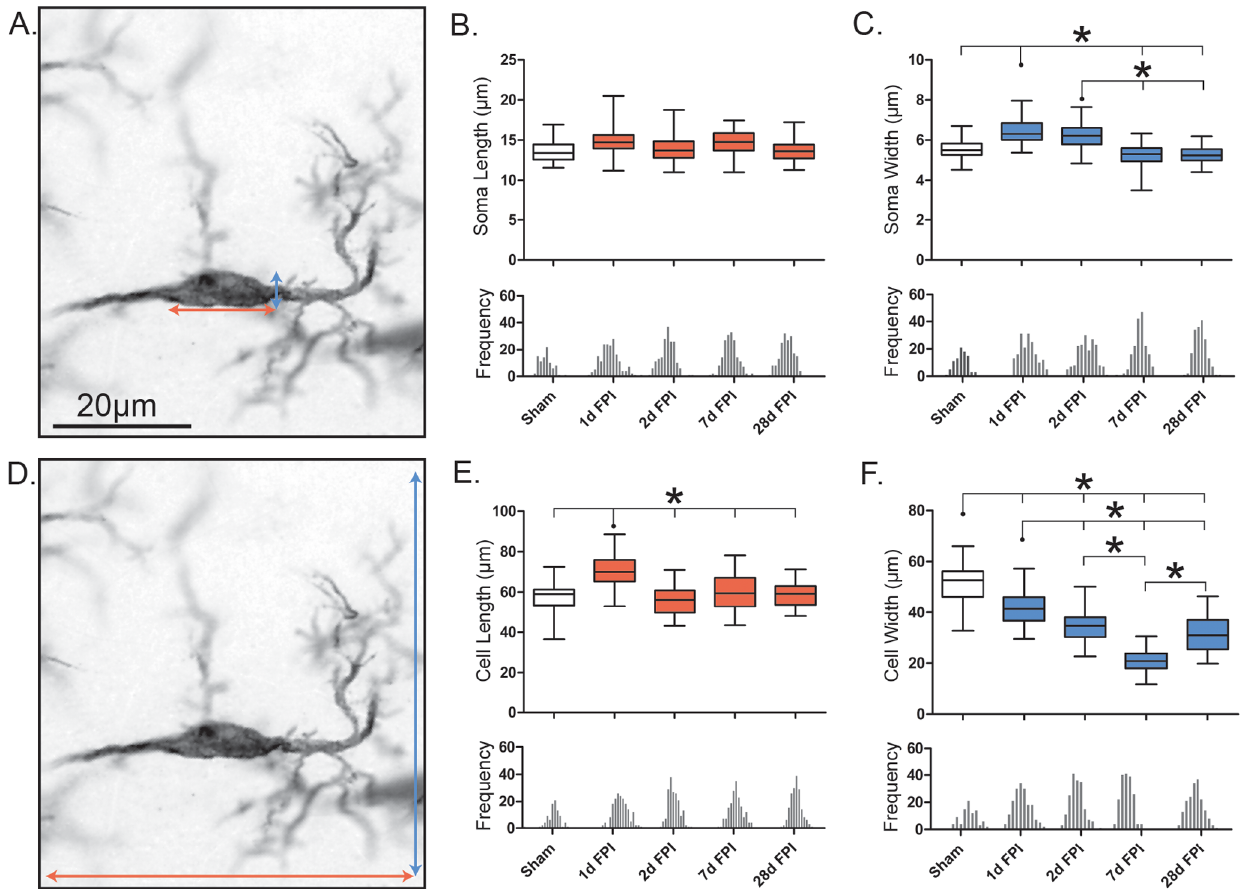
Figure 3. Retraction of planar processes gives the illusion of elongation. Morphological features of rod microglia cells and soma after diffuse brain injury. Rod microglia do not elongate, but rather narrow, post-injury. (A, D) Representative 28 day post-FPI Iba1-positive rod microglia, 100x. The orange and blue arrows illustrate the measured length and width respectively ( m m) of the cell (A) and soma (D). The population of rod microglial cell length (B) and width (C) is described by a box and whisker plot, similarly for the soma length (E) and width (F). Notches on the x-axis of each frequency histogram represent the bin center for each specific time point, the bin center is determined from the total frequency histogram. In all cases a Gaussian distribution was observed. Significance was calculated using the average mean values for each time point (n=3/time point; *, P , 0.05, one-way ANOVA).